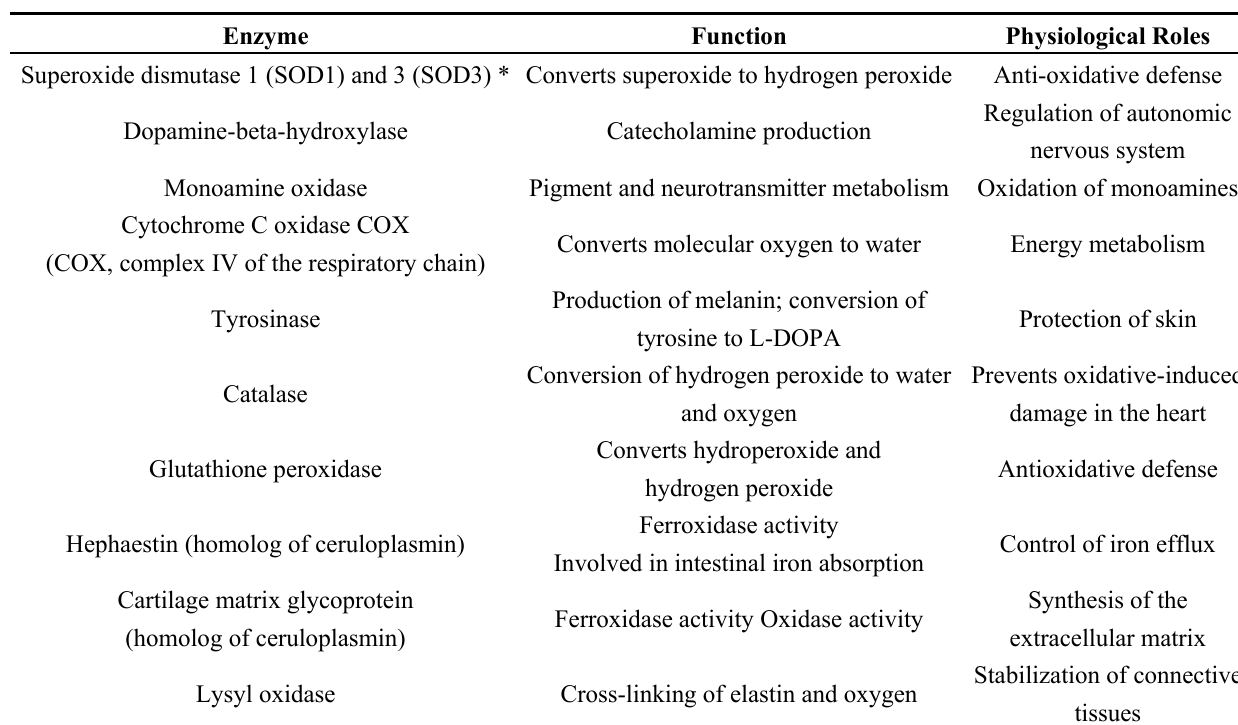
Table 1. Copper-activated enzymes #